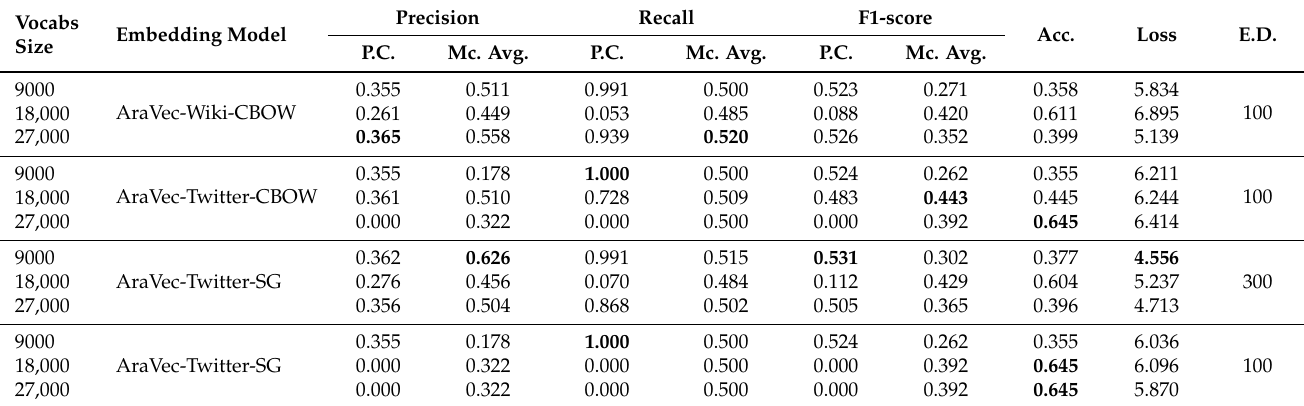
Table 4. The results of adopting the transcripts only by using the Conv1D-DNN model at a learning rate of 5 × 10 − 4 , and at varying vocabulary sizes (E.D. is the embedding dimension). Precision Recall F1-score Vocabs Embedding Model Size